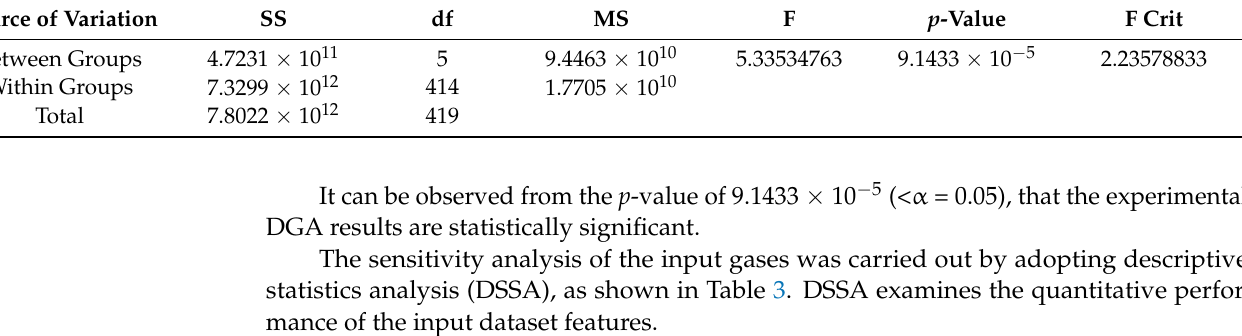
Table 2. Statistical analysis of experimental DGA dataset.